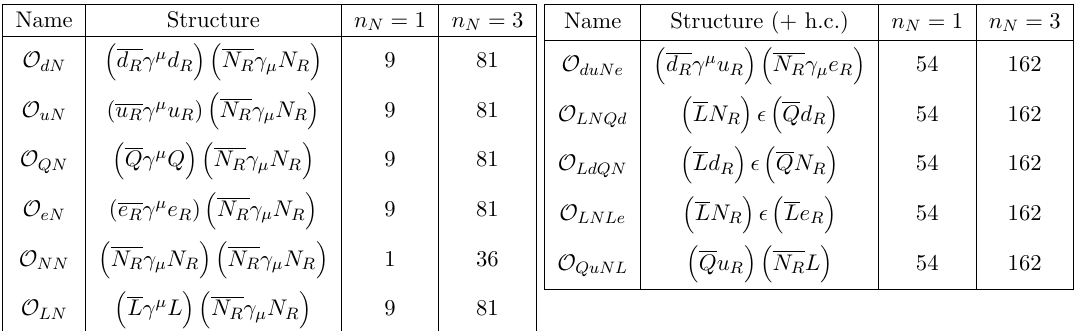
Table 1 . Lepton-number-conserving d = 6 four-fermion operators in N R SMEFT, containing either two (left) or one (right) HNL(s), N R . For each operator structure, we provide the number of independent real parameters for n N = 1 and n N = 3 generations of N R . Note that operators O LNQd and O LdQN have the same particle content, but represent independent Lorentz